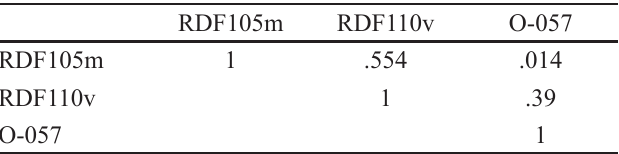
TABLE V - Correlation (r) matrix between the